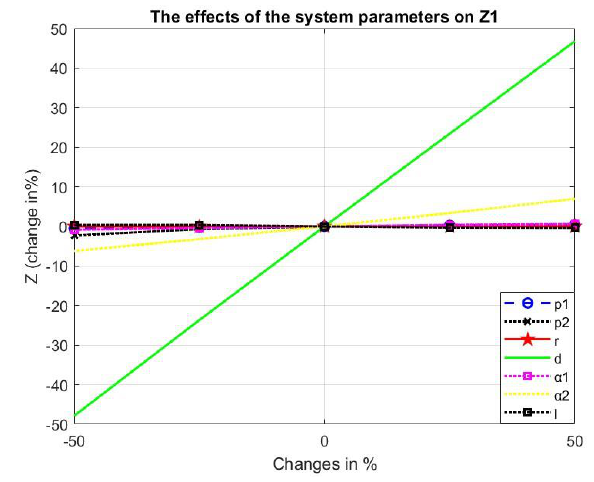
Figure 6. The effects of the system parameters of the numerical example on the total cost of the first model.